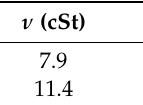
Table 3. Fluid Properties.